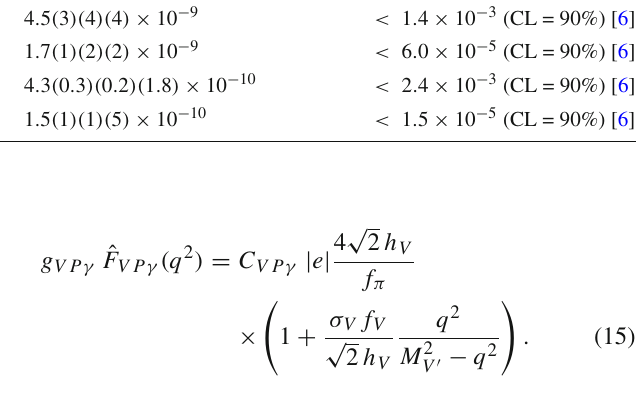
Table 1 Decay widths and branching ratios for the six C -conserving decays η ( (cid:2) ) → π 0 l + l − and η (cid:2) → η l + l − ( l = e or μ ). First error is experimental, second is down to numerical integration and third is due to model dependency Decay Γ th BR th BR exp η → π 0 e + e